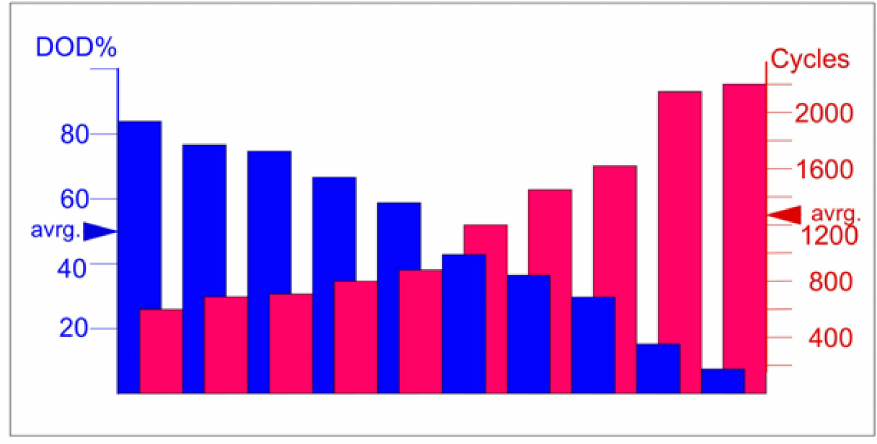
Figure 10. Frequency distribution of DOD and corresponding expected battery duration in